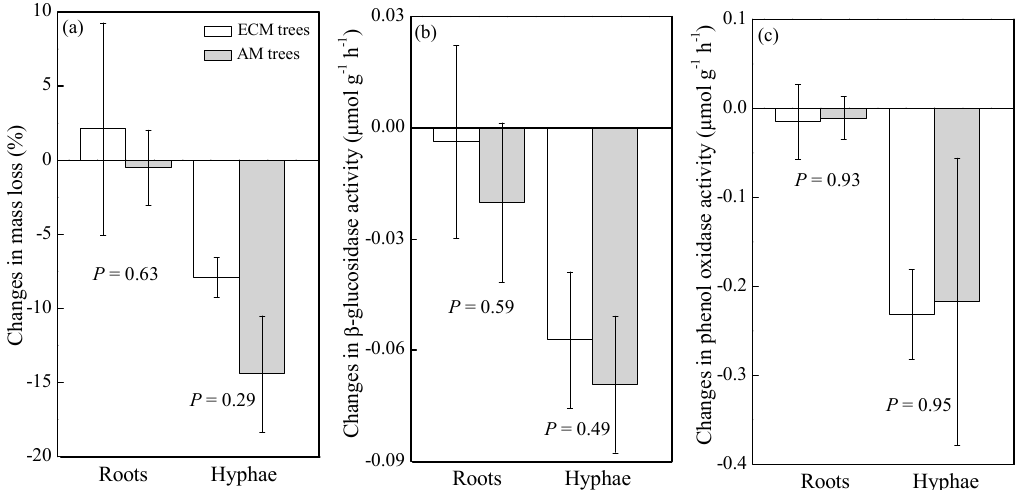
Figure 5. Differences between ectomycorrhizal (ECM) and arbuscular mycorrhizal (AM) trees in their living root (Roots) and mycorrhizal hypha (Hyphae) effects on root litter mass loss ( a ), and activities of β -glucosidase ( b ) and phenol oxidase ( c ). P -values were obtained from linear mixed models, which were conducted to analyze whether there were significant differences between ECM and AM trees in their living root and mycorrhizal hypha effects. Error bars represent 95% confidence intervals (CIs). When 95% CIs do not overlap with y = 0, the presence of living roots or mycorrhizal fungi significantly affects root litter mass loss and enzyme activities.